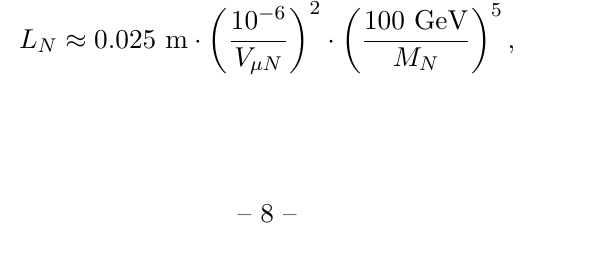
Figure 2 . Decay branching ratios Br( N as a function of M N . Here, i; j = e; (cid:22); (cid:28) denotes lepton (cid:13)avour with i assumed to mix only with the light muon neutrino, V (cid:22)N ratios are independent of V (cid:22)N